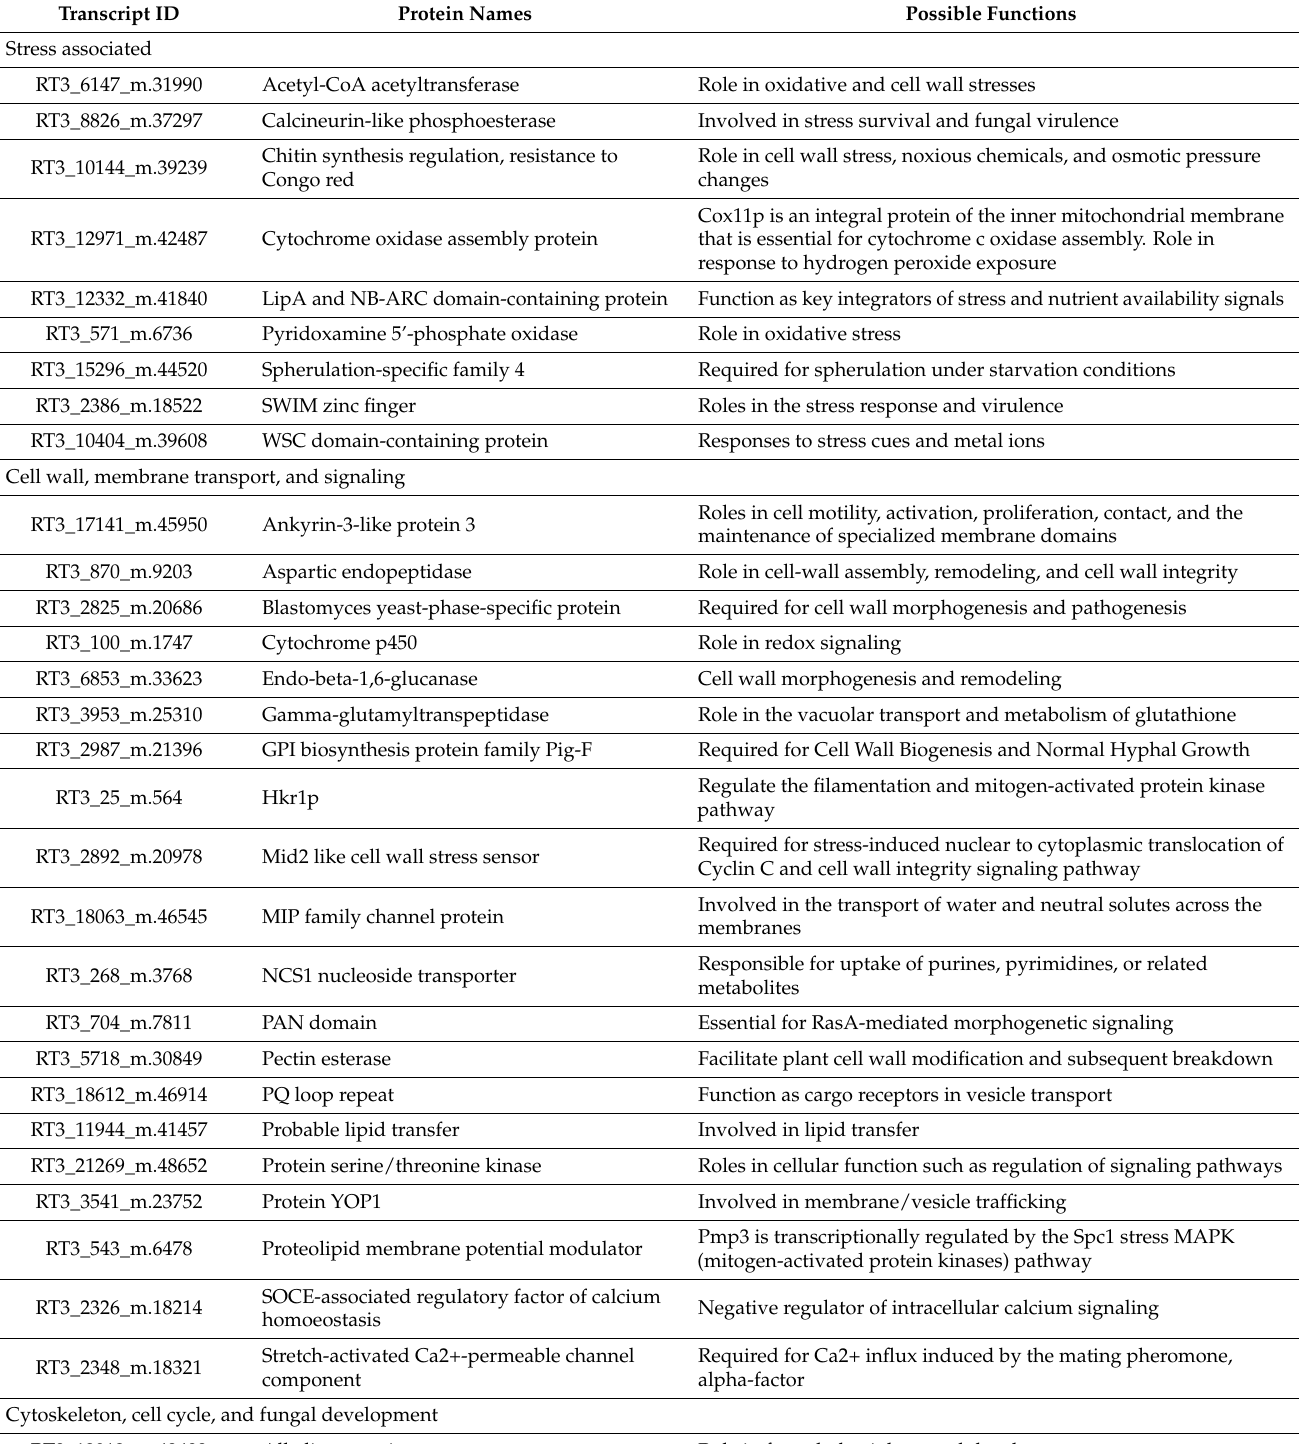
Table 5. Uniquely expressed secretory effector proteins during CAT fusion in C. gloeosporioides